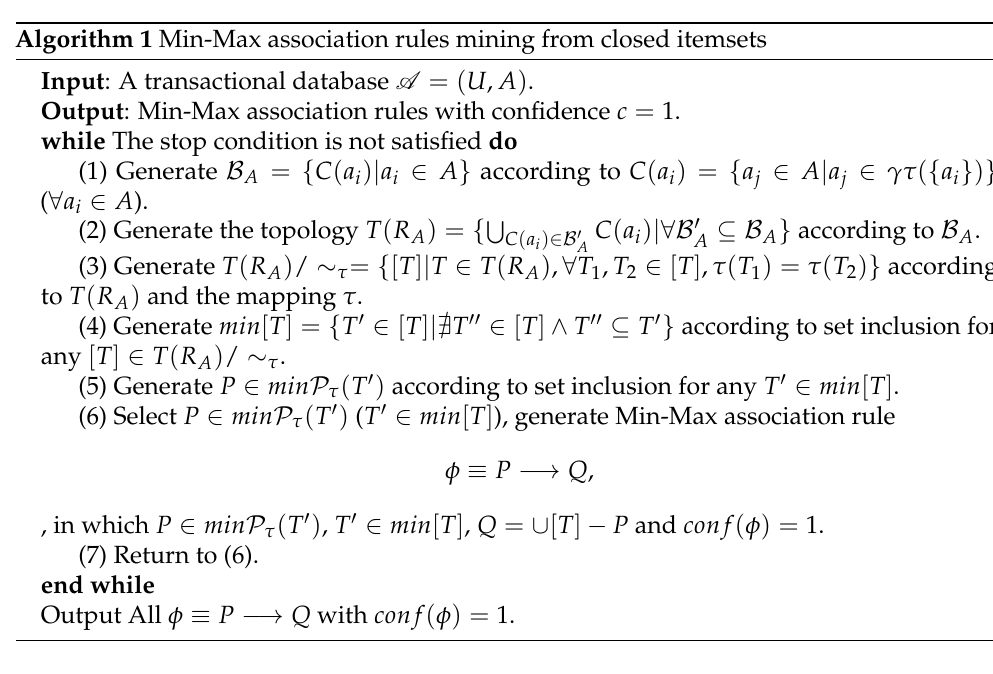
Algorithm 1 Min-Max association rules mining from closed